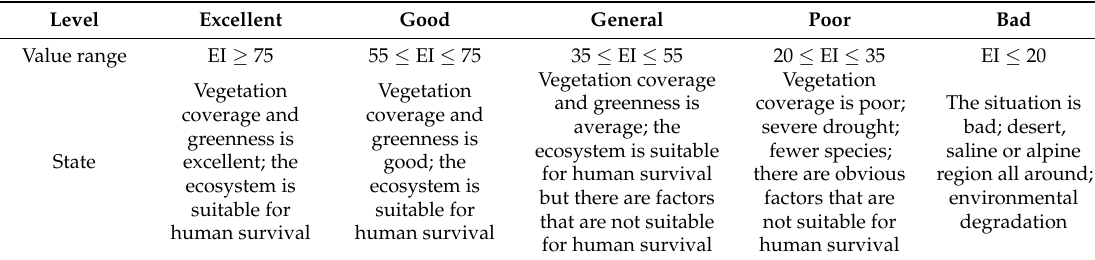
Table 9. Grade of eco-environmental quality [53].